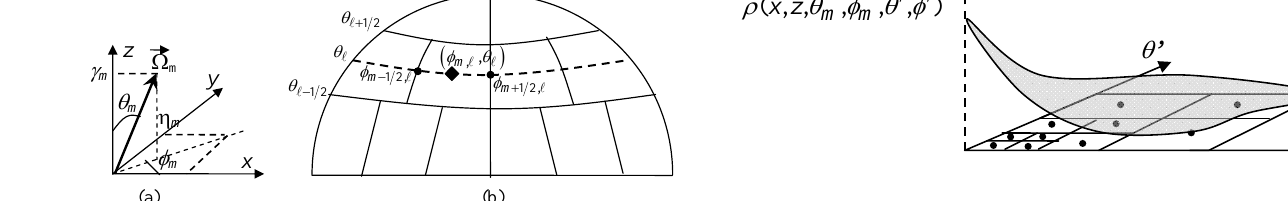
Fig. 5. An adaptive angular quadrature to integrate a in the forward direction highly elongated phase